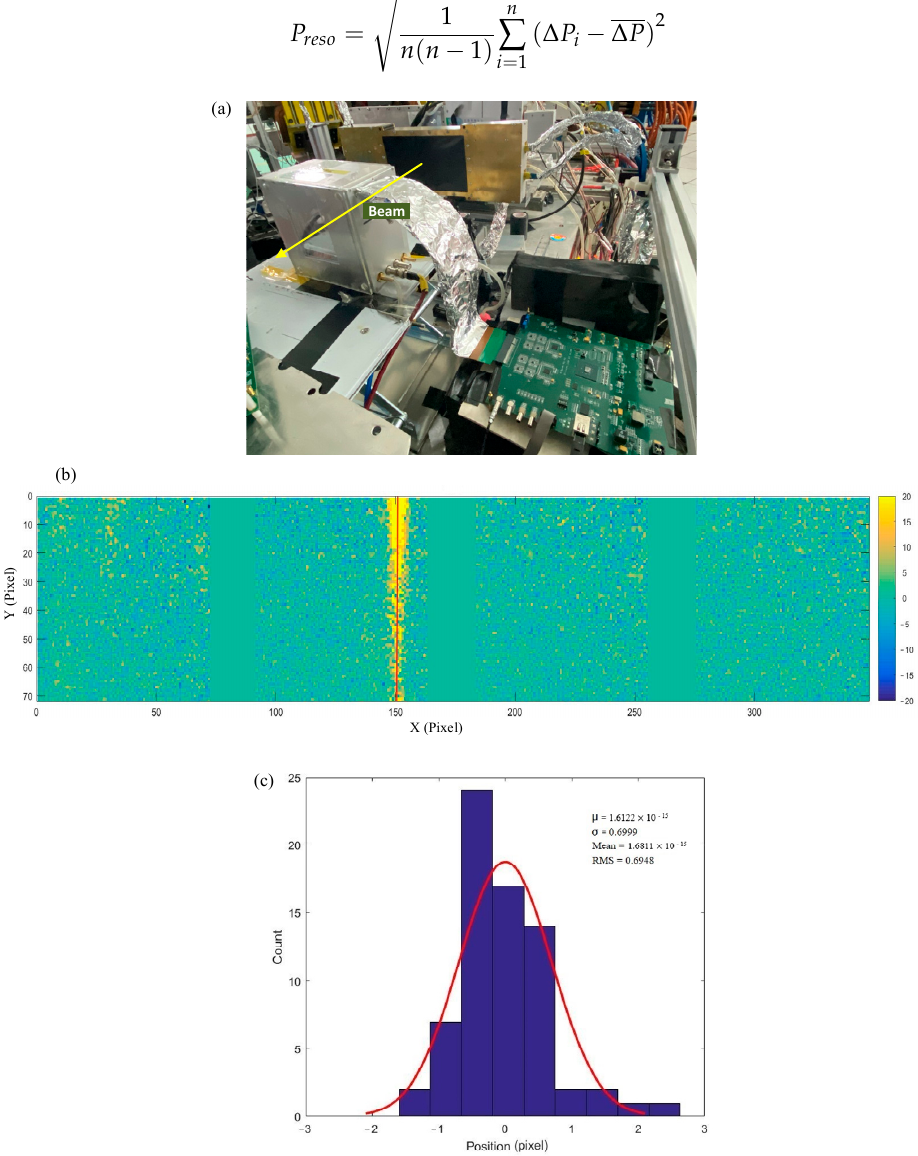
Figure 15. ( a ) Beam test setup of the readout electronics. ( b ) The 2D spectrum of the 40 Ar ion beam. ( c ) Resolution on beam position measurement.